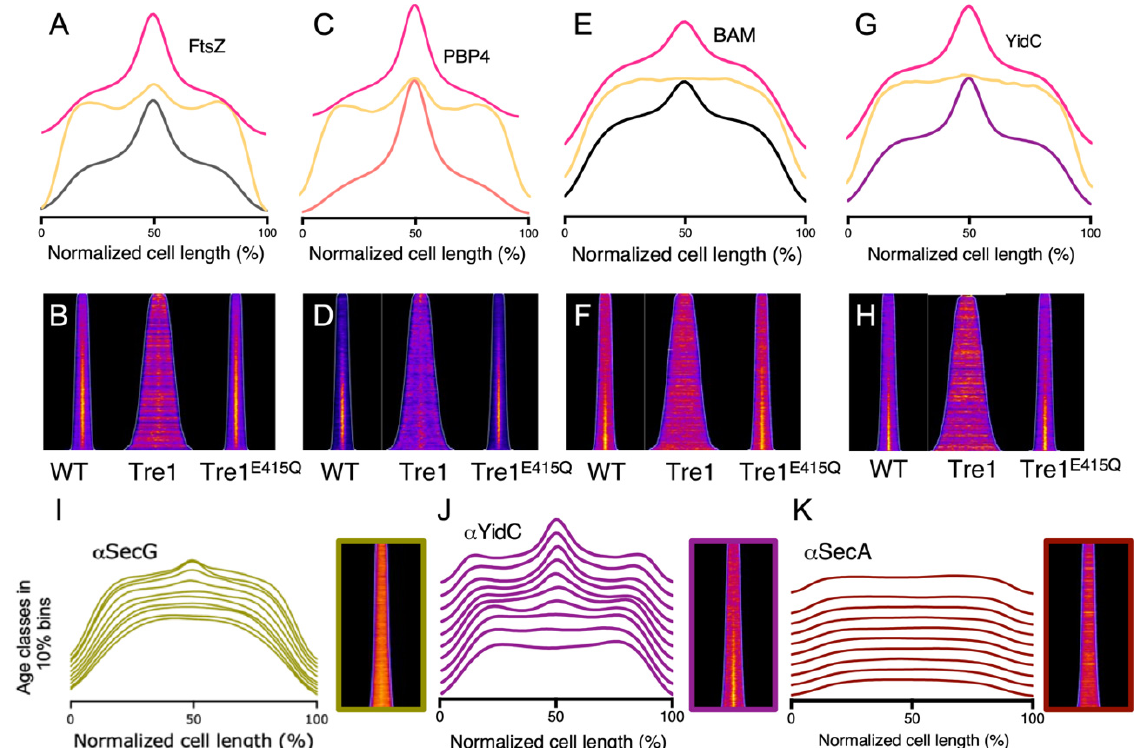
Figure 8. Localization of FtsZ, PBP4, YidC and the BAM complex in LMC500 E. coli wild type cells treated with Tre1 toxin FtsZ inhibitor and wild type E. coli cells immunolabelled for the Sec machinery. The cells were harvested after being grown to steady state in minimal medium at 28 ◦ C (WT), or after expressing the plasmid encoded the Tre1 toxin (Tre) or its inactive variant (Tre1 E415Q ) for a further two mass doubling induced by 0.15% arabinose. ( A , C , E , G ) Fluorescence average profiles of FtsZ, PBP4, BAM and YidC of wild type cells (gray, orange, black and purple line, respectively), after the exposure to Tre1 toxin (yellow line) or to its inactive version (magenta line). ( B , D , F , H ) Fluorescence demographic maps of FtsZ, PBP4, BAM and YidC. Midcell Z-ring formation is impaired in cells expressing the Tre1 toxin ( A , B ). PBP4 midcell recruitment is strongly compromised by Tre1 expression ( C , D ). The BAM complex is evenly distributed along the cell envelope, upon Tre1 toxin induction. IM insertase YidC midcell presence is also completely abolished without the Z-ring formation. Number of cells analyzed were for α FtsZ 3477, 1100 and 3670 for WT, Tre1 and Tre1 E415Q , respectively, for α PBP4 2392, 1607 and 3769 for WT, Tre1 and Tre1 E415Q , respectively, for α BAM 2971, 1250 and 2563 for WT, Tre1 and Tre1 E415Q , respectively and for α YidC 2698, 585 and 1998 for WT, Tre1 and Tre1 E415Q , respectively. ( I , J , K ) Wild-type E. coli cells were immunolabelled for the Sec machinery components SecG, YidC and SecA. The fluorescence profiles were binned into 10 age classes (10% to 100%) and plotted as function of the normalized cell length. In both binned profiles, the IM subunit YidC exhibits a midcell accumulation around 40% of the cell division cycle. On the contrary, SecA binned profiles do not show any midcell enrichment, whereas SecG is only present in deeply constricting cells. The numbers of cells analyzed were 5329, 6979 and 3654 for α SecG, α YidC and α SecA,